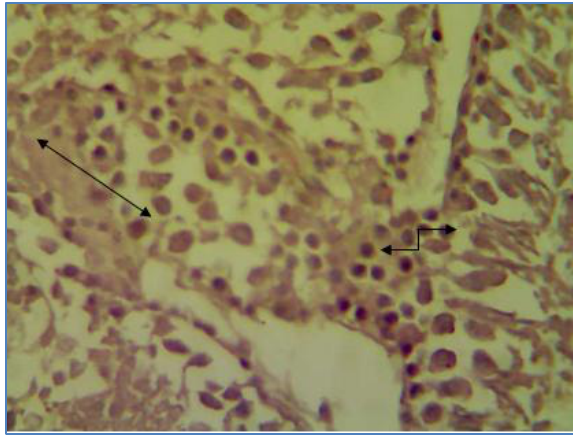
Figure, 14: Section in testis of animal treated with CdCl 2 (G1) shows deformity Seminiferous expressed one part with incomplete spermatogenesis ( ) process ( ), (H and E stain40X).